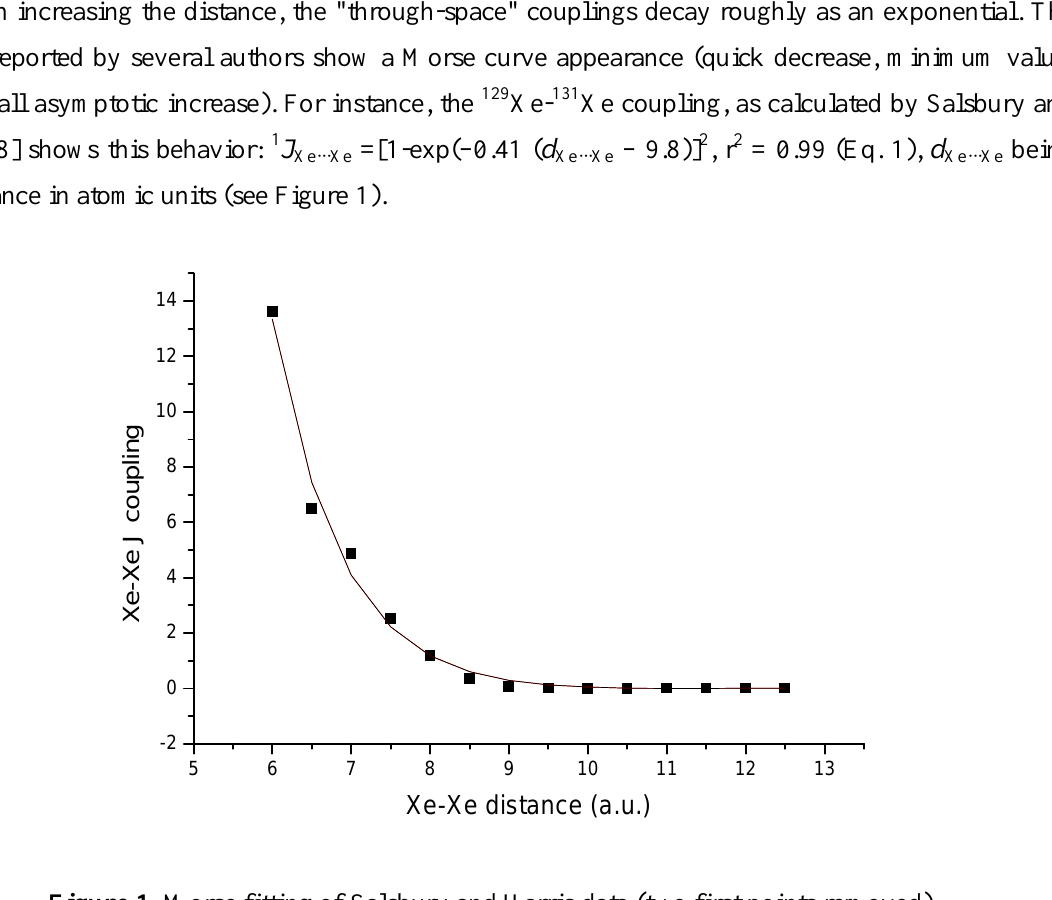
Figure 1. Morse fitting of Salsbury and Harris data (two first points